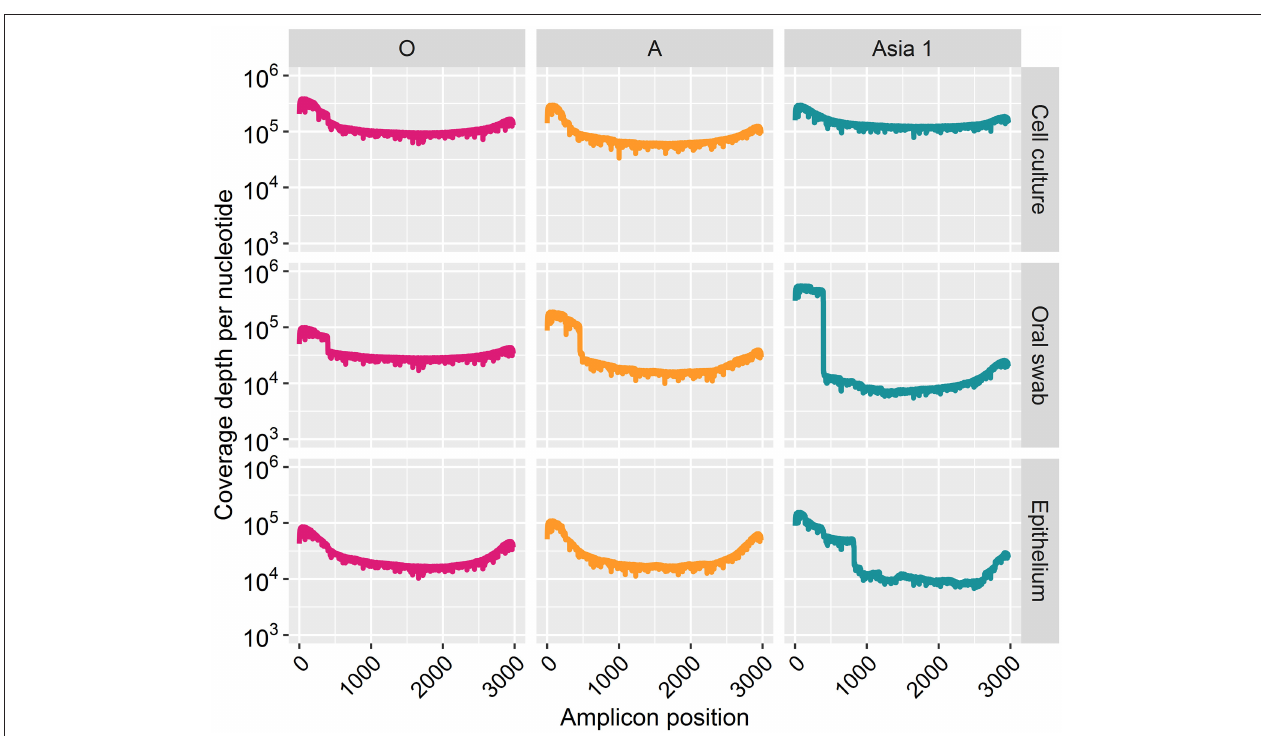
FIGURE 4 | Coverage depth at each nucleotide position of the sequenced amplicon for every sample after 30h of nanopore sequencing.